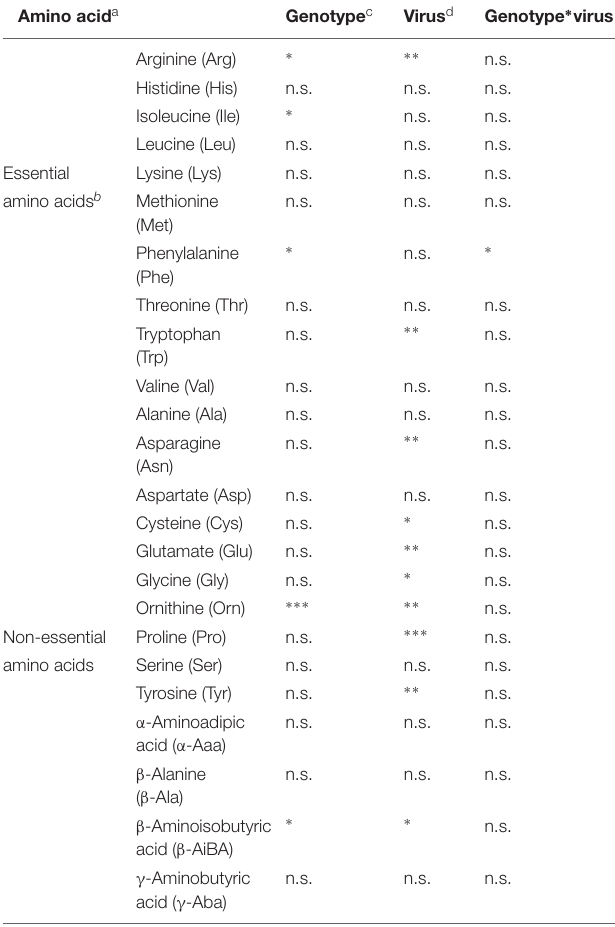
TABLE 1 | ANOVA results for the effects of B. tabaci genotypes and virus (TYLCV) on the mol% of free amino acids in B. tabaci